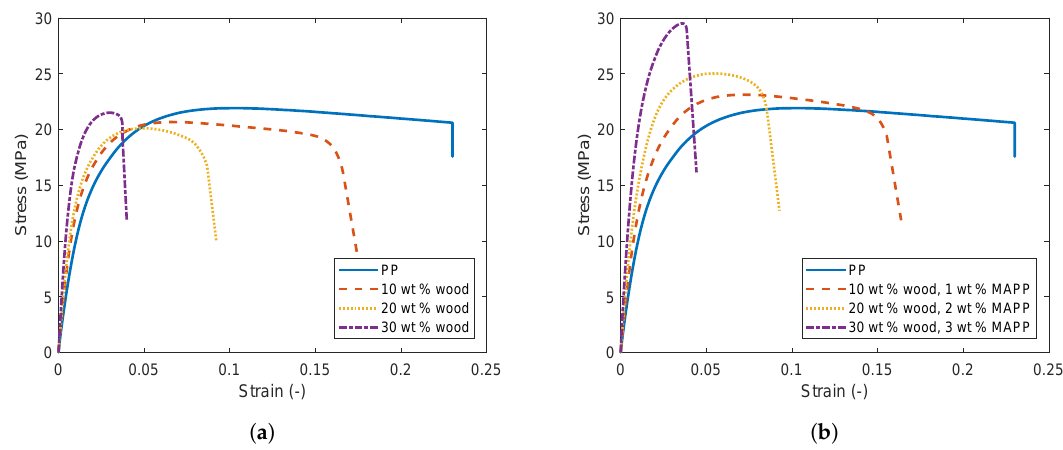
Figure 1. Selection of typical stress-strain curves for various compositions: ( a ) without maleic anhydride grafted polypropylene (MAPP); and ( b ) with